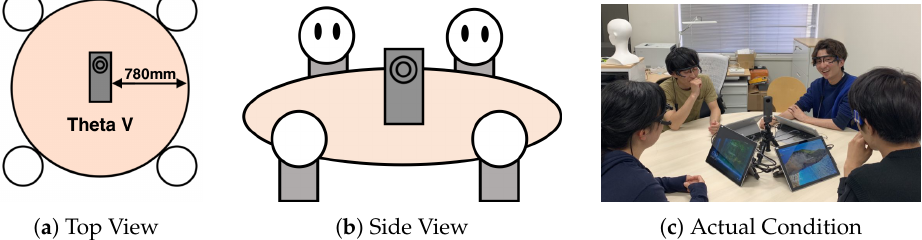
Figure 3. The Device Position. RICOH THETA V [41] is located at the center of the circular table. It is located approximately 780 mm from the edge of the table. ( a ) shows the view of the meeting condition from the top of the room. ( b ) shows the view of the meeting condition from the side of the room. ( c ) shows the actual scene of performing an